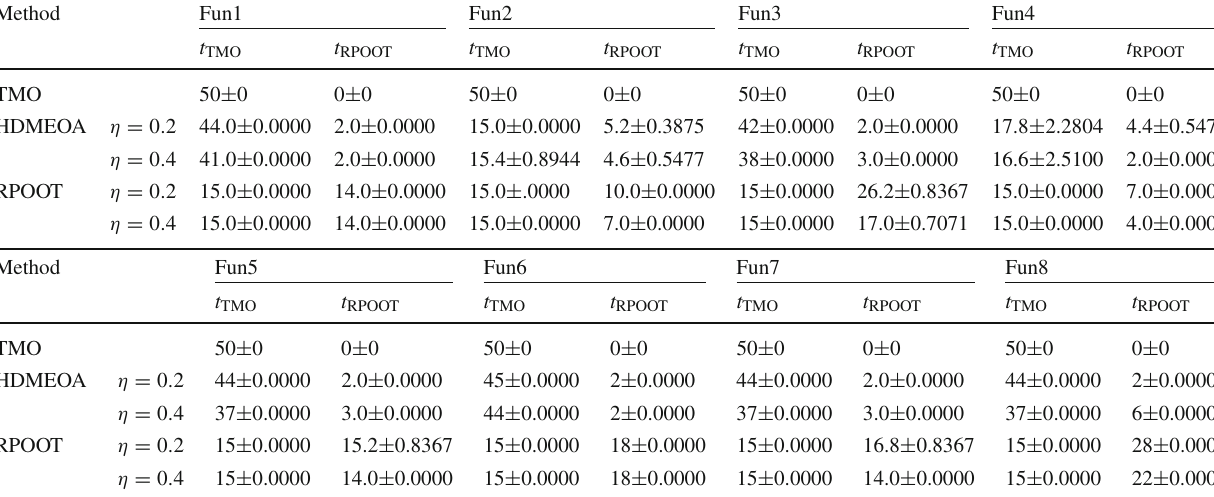
Table 5 NumTR comparison of three methods under linear environmental changes Method Fun1 Fun2 Fun3